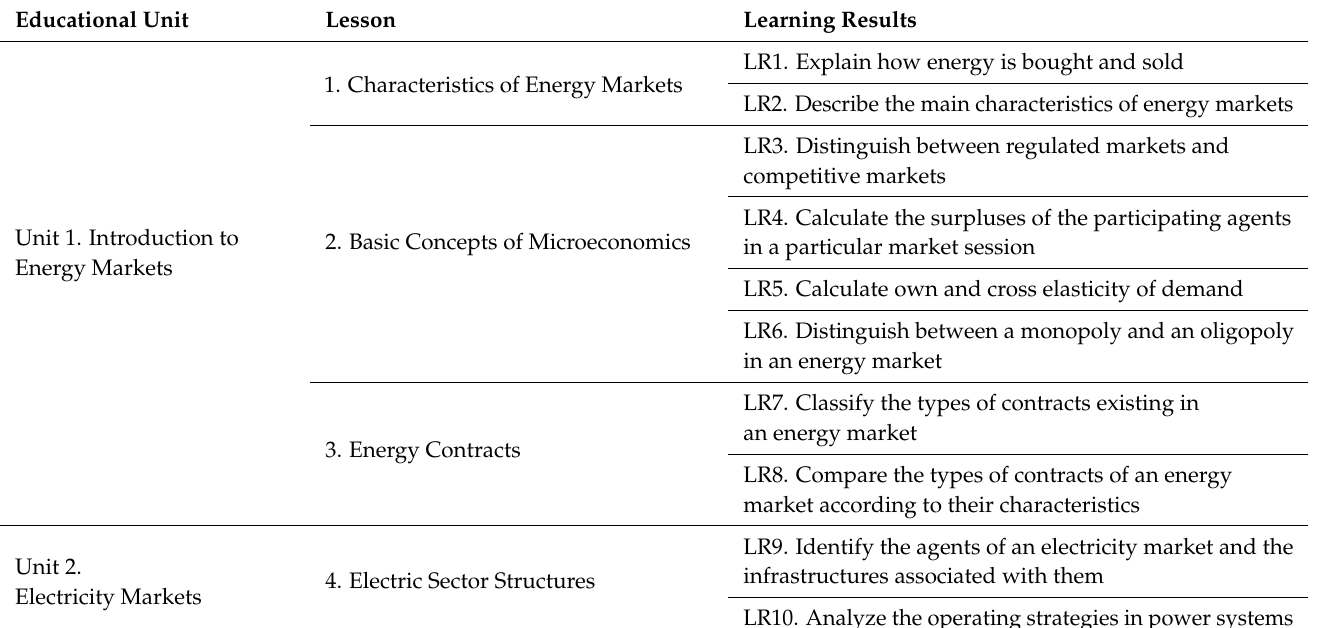
Table 3. Syllabus and learning results of the course on energy